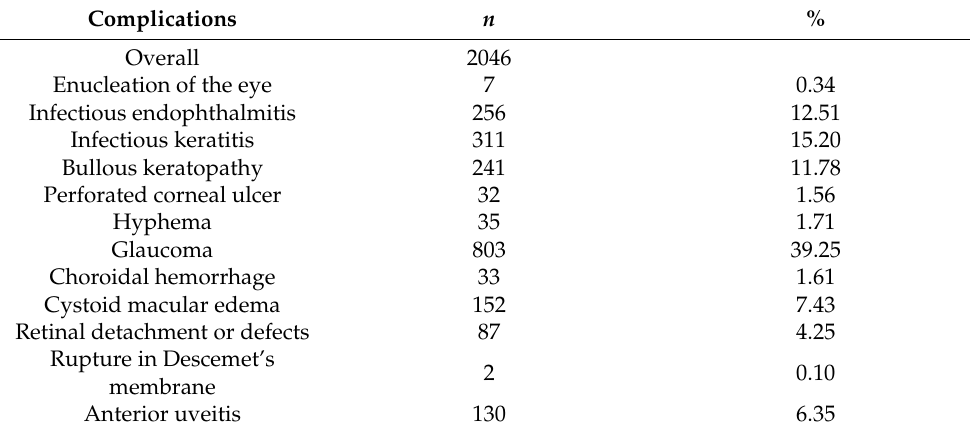
Table 2. Distribution of serious